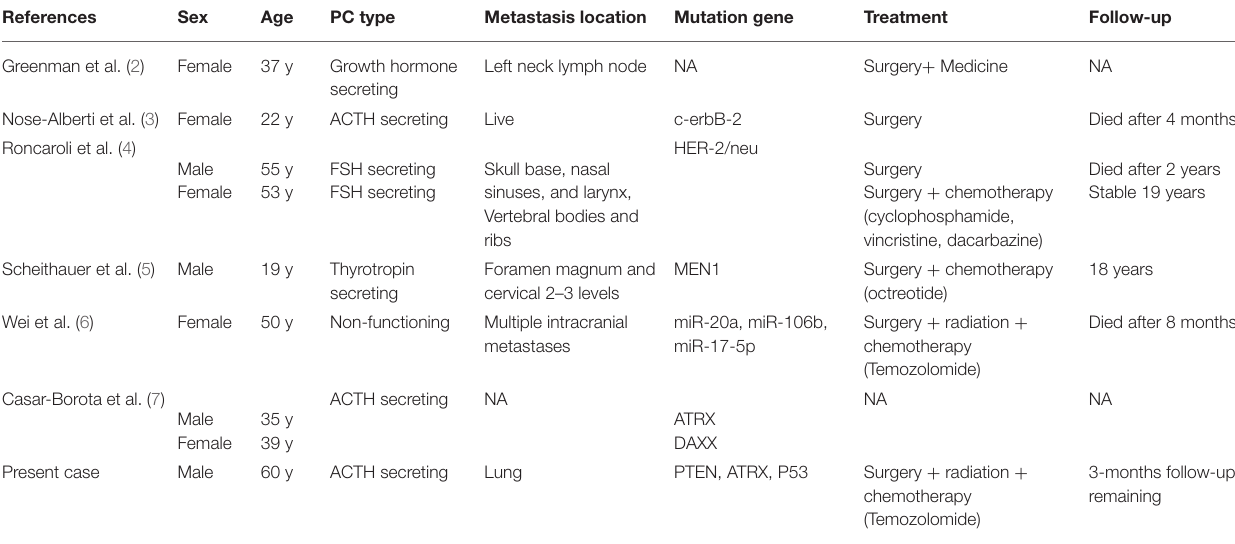
TABLE 1 | Summary of the literature regarding mutant genes involved in PCs